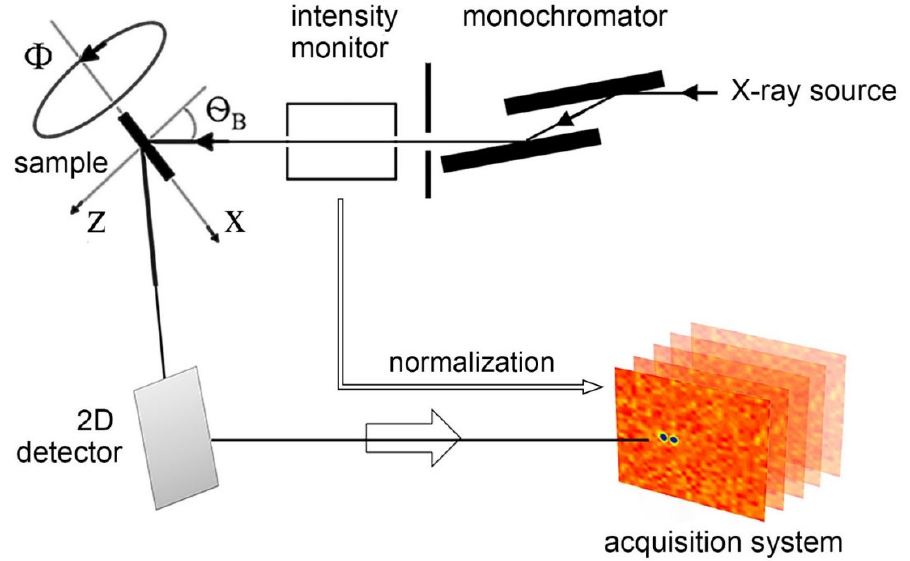
Figure 1. Schematics of set-up for measuring 2D IPs in the multi-frames mode. A set of frames is acquired for the crystal sample position fi